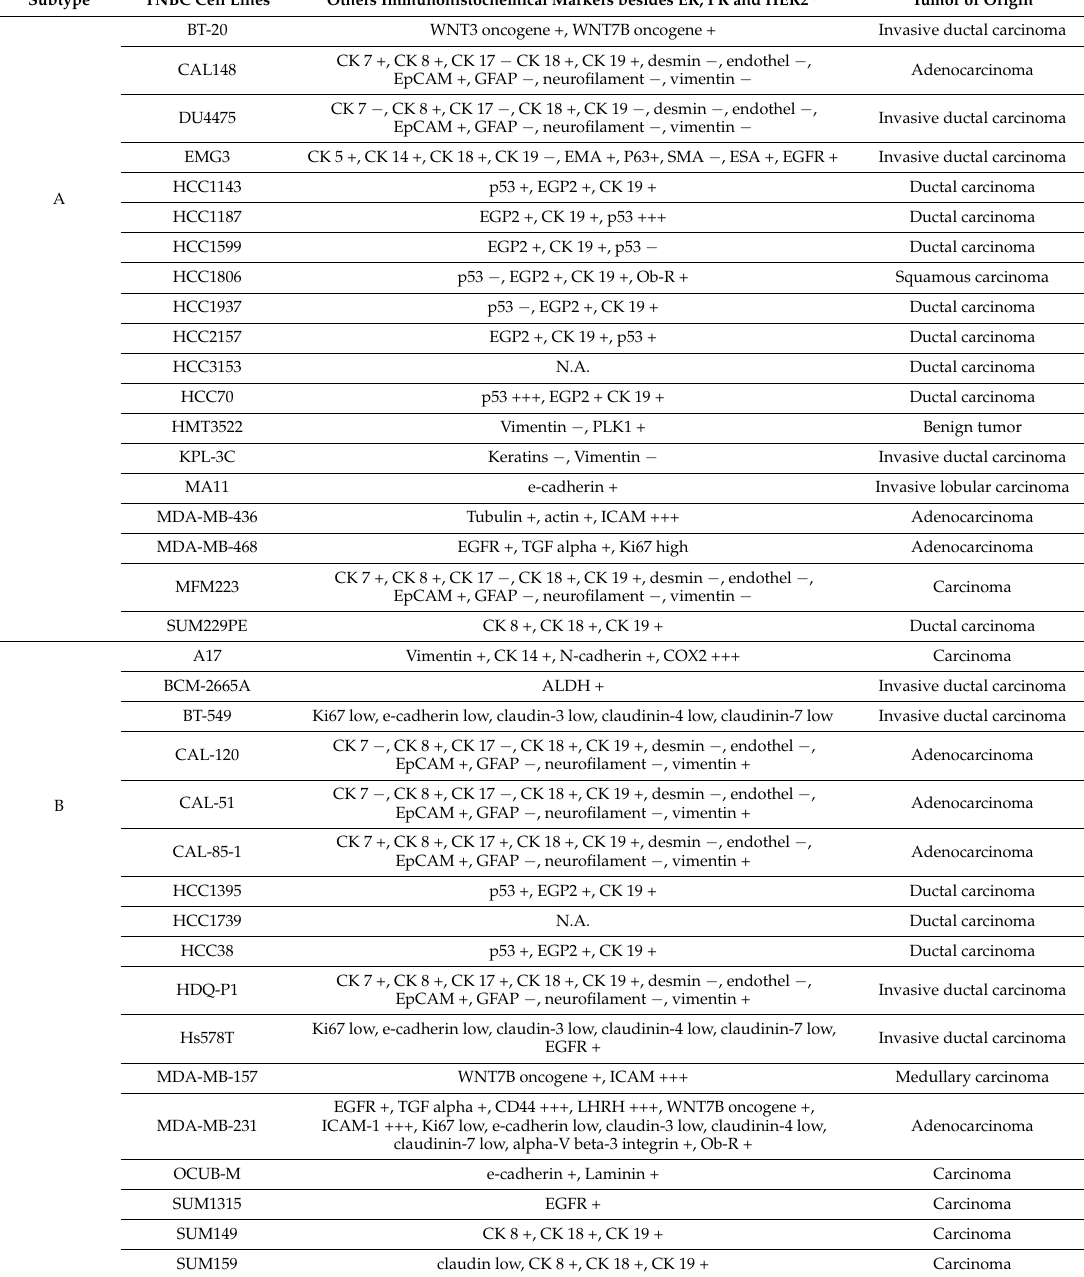
Table 1. Characterization of the main triple negative breast cancer (TNBC) cell lines according to the subtype and molecular